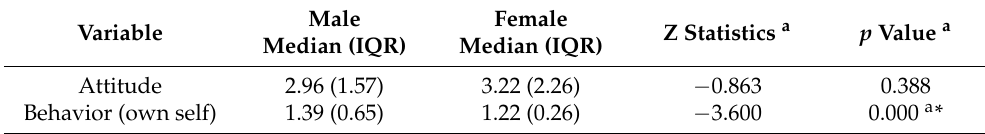
Table 2. Association between gender and students’ attitudes and behavior towards academic dishonesty.